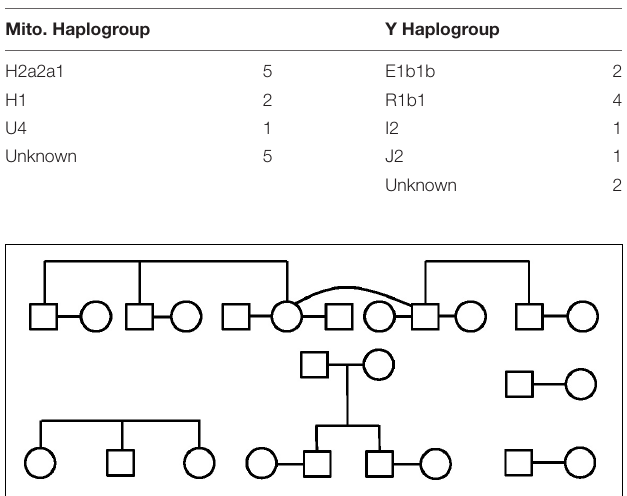
independent first-generation founder individuals as shown in Figure 3 . Since these are inferred from the genetics and family structure of the current population, any founding individuals who did not contribute genetically to the current island population will not be detected in these